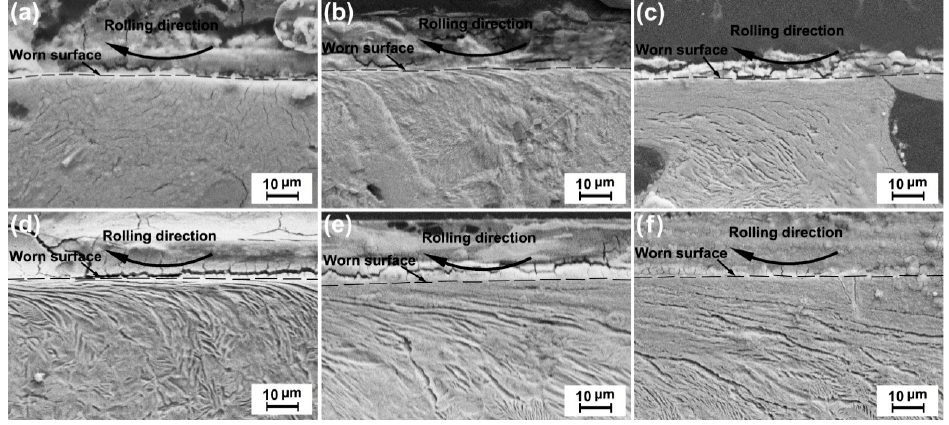
Figure 9. Wheel-material plastic-deformation under a normal load of 50 N at different sliding velocities: ( a ) D’ 6.3 × 10 4 mm/min, ( b ) D’, 9.42 × 10 4 mm/min, ( c ) D’, 12.54 × 10 4 mm/min, ( d ) S, 6.3 × 10 4 mm/min, ( e ) S, 9.42 × 10 4 mm/min, and ( f ) S, 12.54 × 10 4 mm/min.